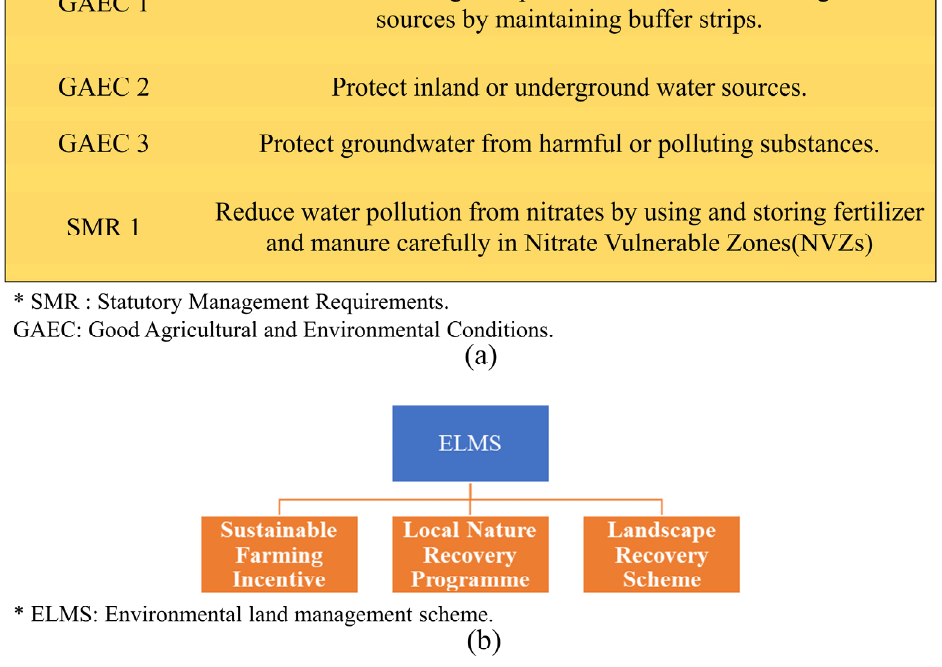
Figure 2. Gross compliance system and newest schemes related to DWP control. ( a ) The gross com- pliance system related to controlling DWP; ( b ) Three projects in the environmental land management scheme related to DWP control.